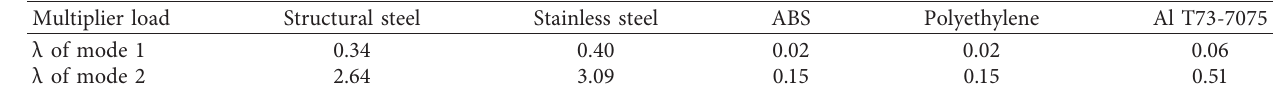
Table 4: Results of the buckling behavior for various